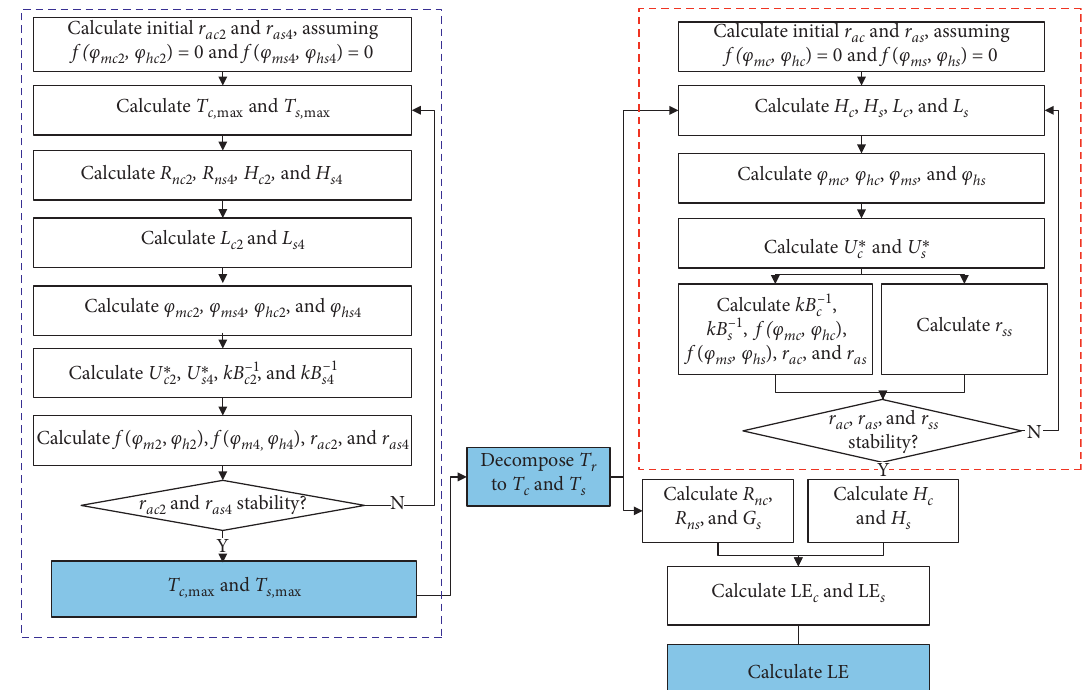
Figure 2: Computational procedure of LE and its components (LE